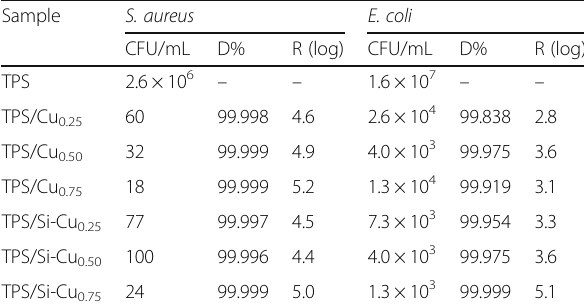
Table 1 Antimicrobial activity of TPS composite films containing Cu and Si-Cu particles against S. aureus and E.